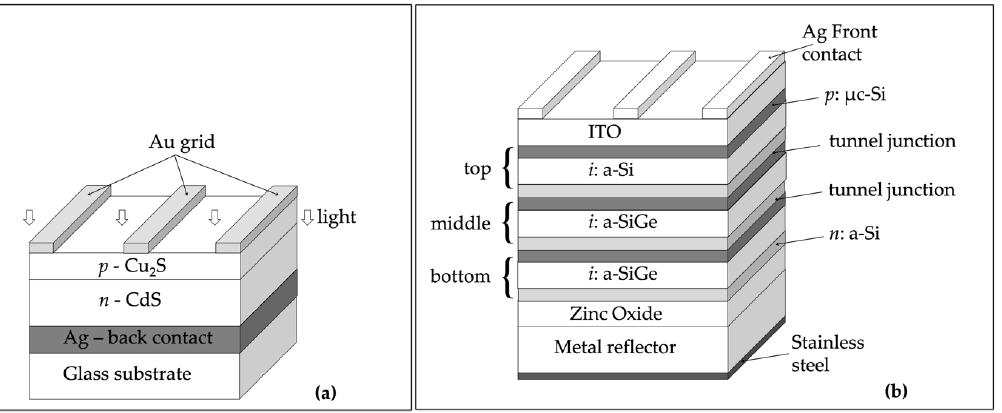
Figure 3 . ( a ) schematic representation of the front-wall Cu 2 S/CdS solar cell in which light enters the device from the top. Solar cells made with Cu 2 S layer, topotaxially grown on CdS, exhibited an e ffi ciency close to 10%. ( b ) a-SiGe-based triple junction, which exhibited a stabilized total-area efficiency of 12.1% on laboratory scale.